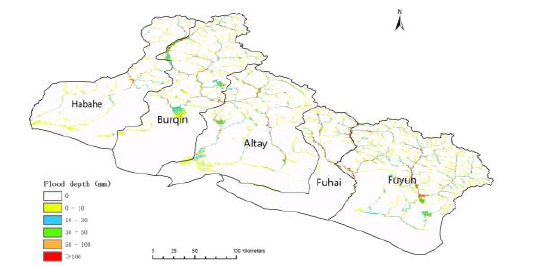
Figure 6. The depth of snowmelt runoff on May 9 of the